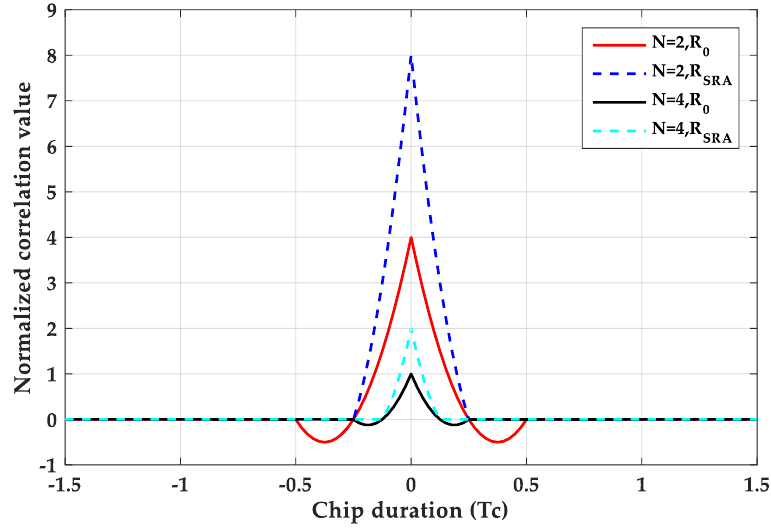
Figure 9. The combination results of correlation functions by SRSA.